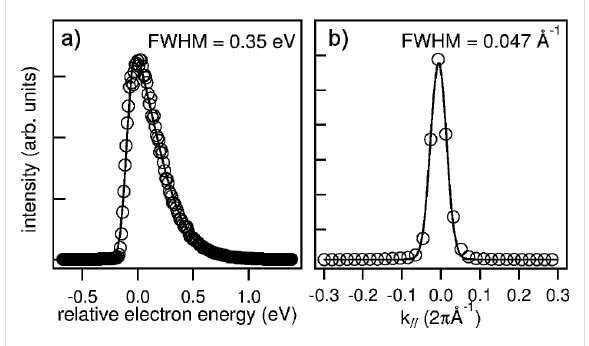
Figure 5: a) The energy distribution of the electron beam emitted from the LaB 6 source acquired by keeping the sample below the MEM tran- sition using a negative start voltage bias. The intensity-vs-energy curve is obtained in dispersive plane operation, in which the exit plane of